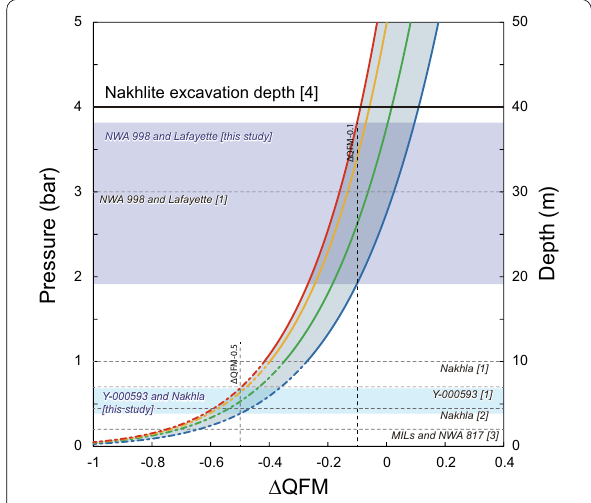
Fig. 3 Total sulphur content vs. f O 2 (expressed as ΔQFM) degassing simulations at 0.04–5 bar. Degassing models calculated with D-Compress are shown for an open C–S–O–H system. For close-system degassing curves, see Additional file 1: Figure S4. At the pressure range below 1 bar (dashed-dotted line), the analytical continuation of the modelled curves was utilised to describe the relationship between pressure and f O 2 based on the criterion R 2 1. The burial depths are cited from [1] Mikouchi et al. (2006); = [2] Mikouchi and Miyamoto (2002); [3] Mikouchi et al. (2012). The nakhlite excavation depth is cited from [4] Cohen et al. (2017). In this study, the light blue regions are estimated to be the burial depth range of NWA 998 and Lafayette (ca. 30–40 m) and Y-000593 and Nakhla (< 7